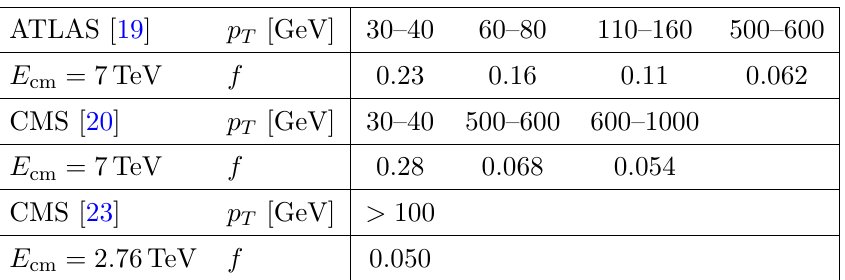
Figure 12 . Comparison of our numerical results for the di(cid:11)erential jet shape (cid:26) ( r ) and the ATLAS data of [19], for the same kinematics as in (cid:12)gure 11.